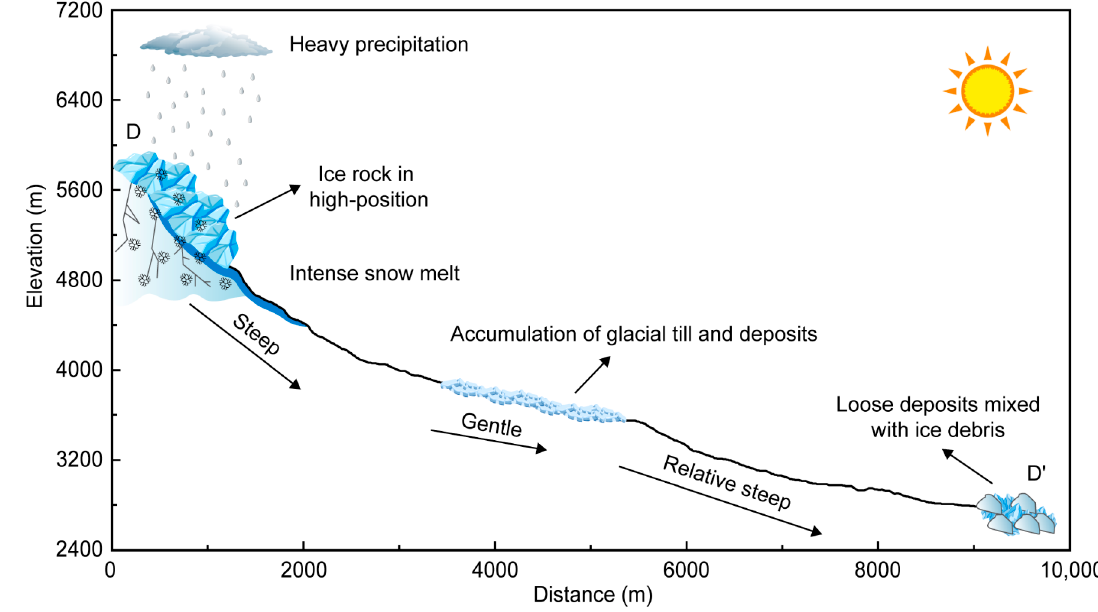
Figure 10. Schematic diagram of the Sedongpu Basin. DD’ see Figure 3.